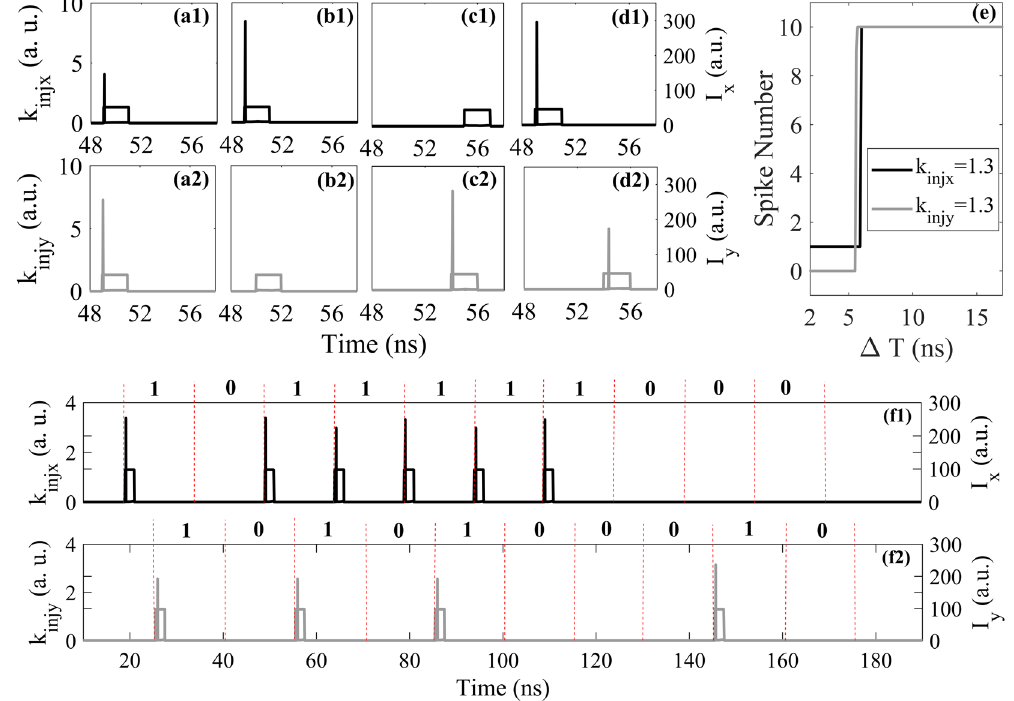
Figure 7. The response outputs of VCSEL-SA subject to two EIOPs for four representative cases. ( a ) the time windows of EIOPs are completely overlapped, ( b ) the EIOP injected into XP arrives earlier,( c ) the EIOP injected into YP arrives earlier, ( d ) two EIOPs are well separated. ( e ) Spike numbers as functions of Δ T for k injx = 1.3 and k injy = 1.3. The response outputs of VCSEL-SA subject to pseudo-random bit sequences in XP ( f1 ) and YP ( f2 ) mode for Δ T = 15